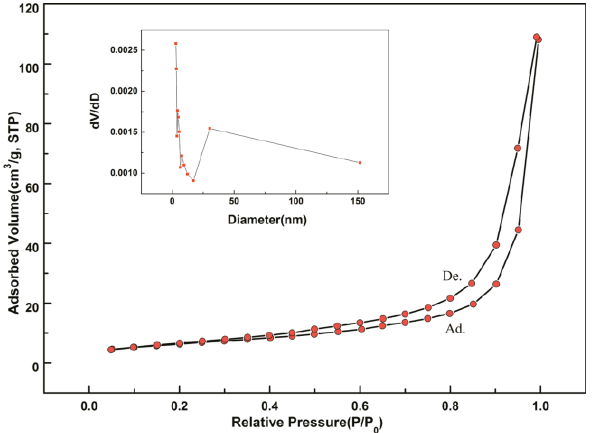
Figure 3. TG-DTA curves of the uncalcined K + / HT sample.